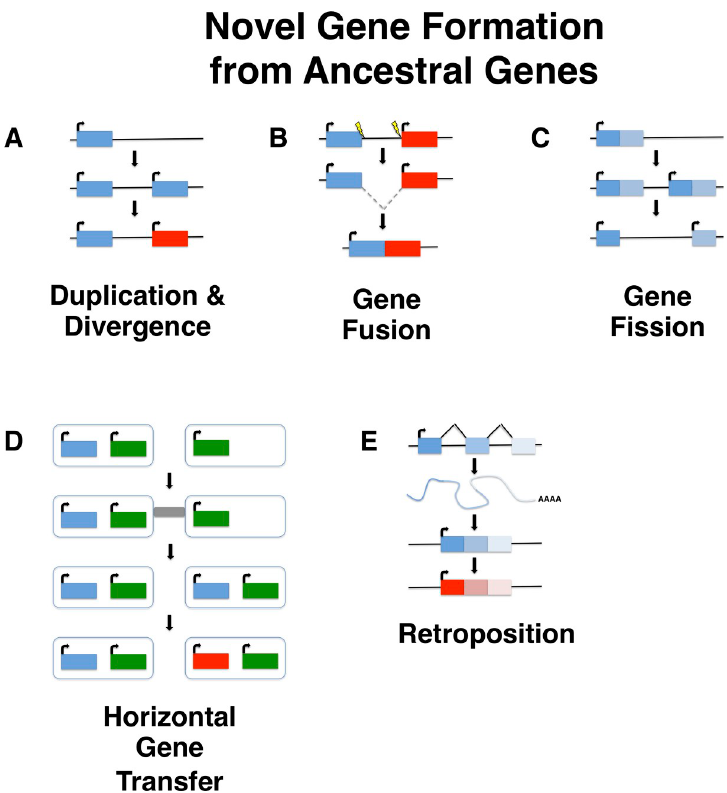
Fig 2. Novel gene formation from ancestral genes. Novel genes can be formed from ancestral genes through a variety of mechanisms. Inspired by Table 1 from [7]. (A) Duplication and divergence. Following duplication, one copy experiences relaxed selection and gradually acquires novel function(s). (B) Gene fusion. A hybrid gene formed from some or all of two previously separate genes. Gene fusions can occur by different mechanisms; shown here is an interstitial deletion. (C) Gene fission. A single gene separates to form two distinct genes, such as by duplication and differential degeneration of the two copies [8]. (D) Horizontal gene transfer. Genes acquired from other species by horizontal transfer undergo divergence and neofunctionalization. (E) Retroposition. Transcripts may be reverse transcribed and integrated as an intronless gene elsewhere in the genome. This new gene may then undero divergence.